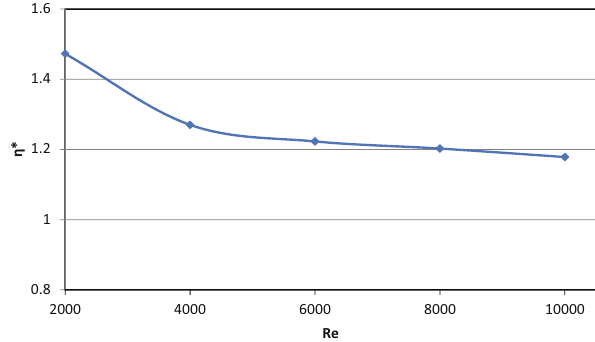
Figure 9: The changes in the maximum heat transfer performance ( η * ) versus the Reynolds number in di ff erent pitches.